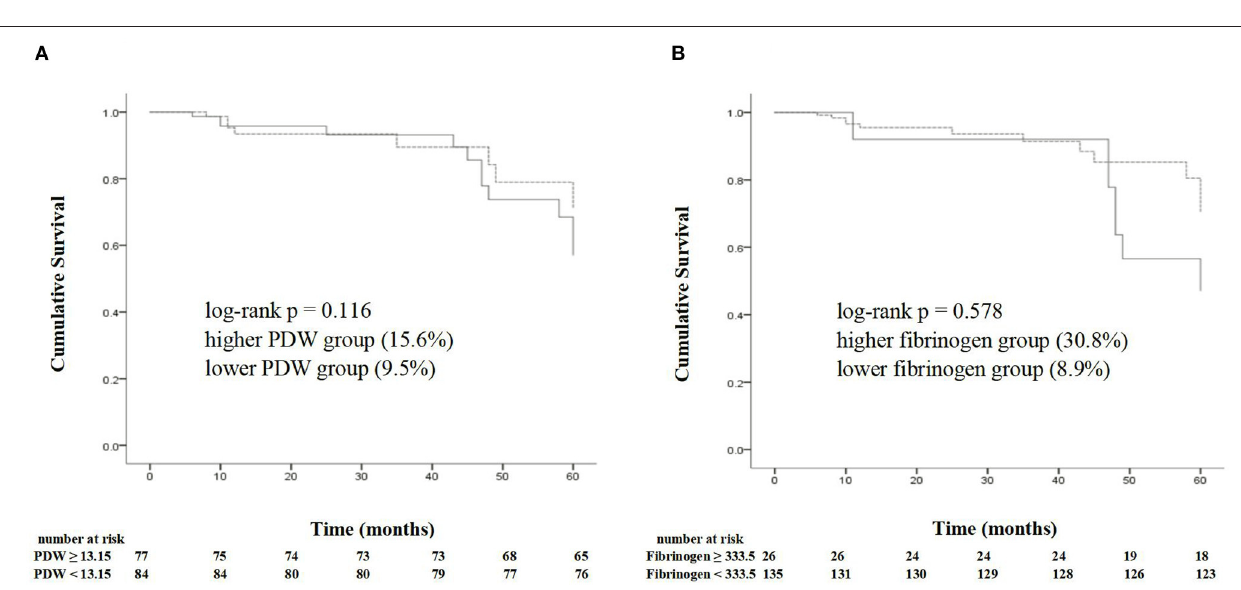
study were patients with stable angina pectoris with